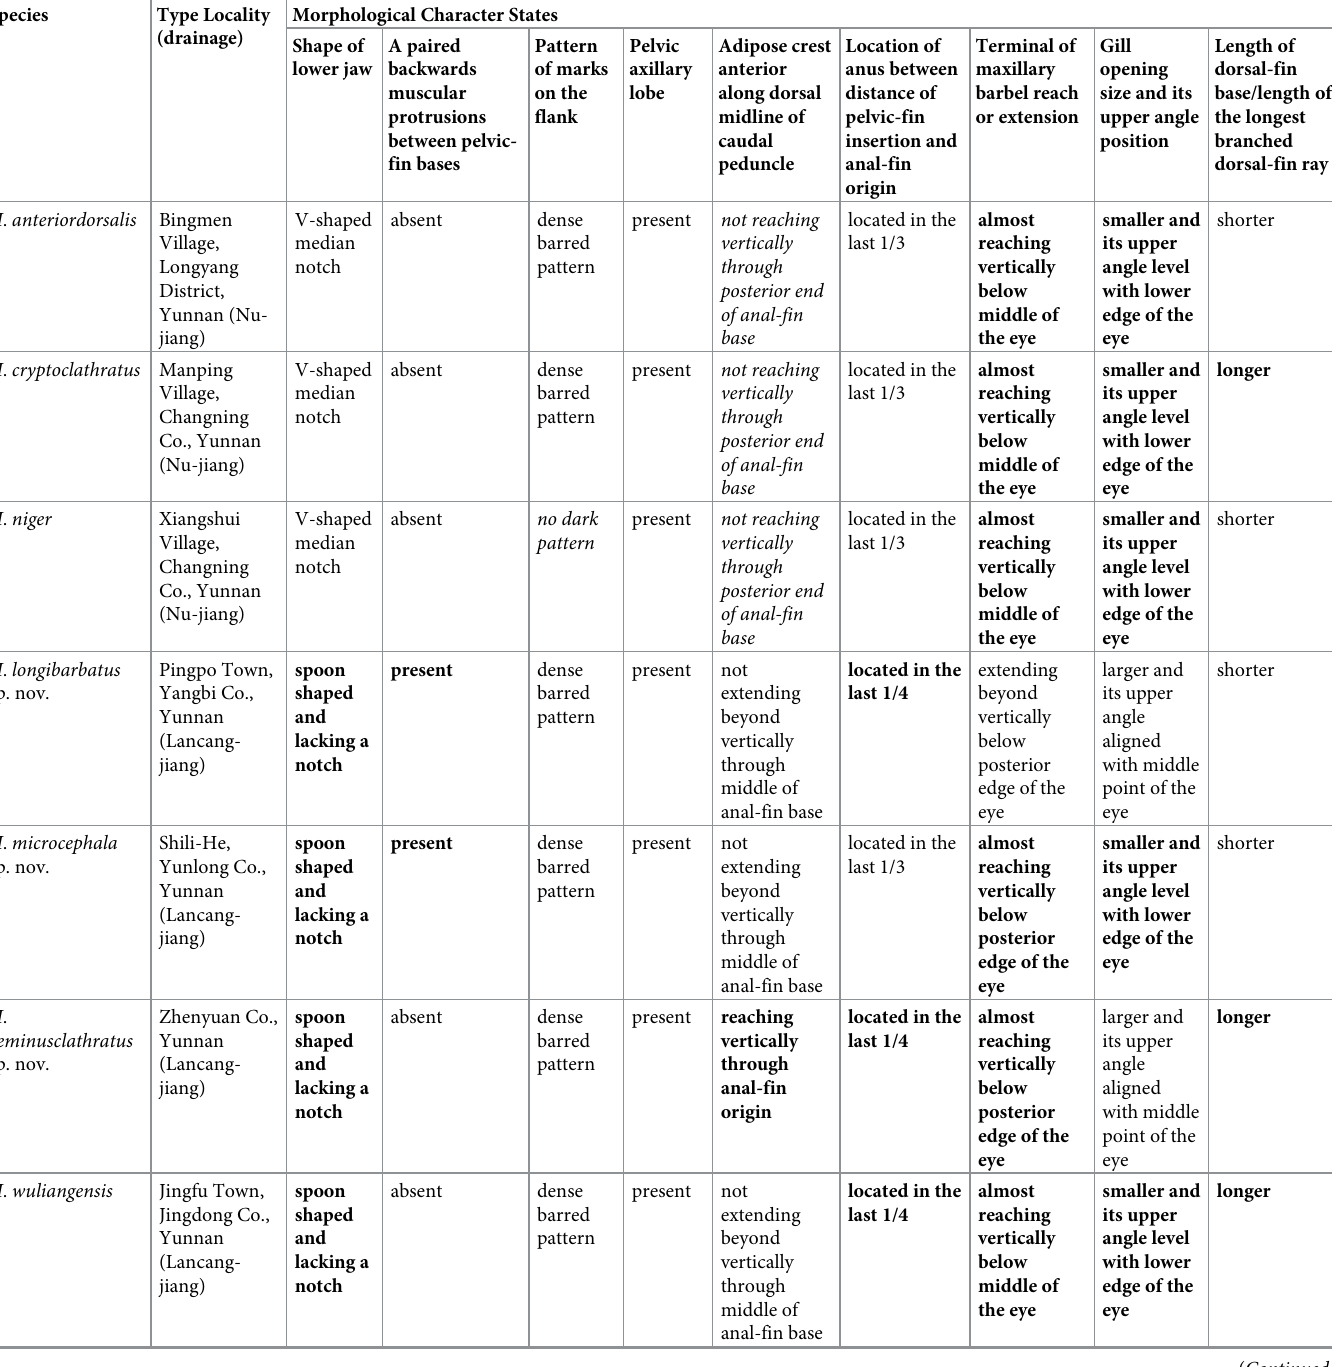
Table 2. Comparisons of characters among the species of the densely-scaled group of Homatula from the Nu-jiang (the upper Salween River), the Lancang-jiang (the upper Mekong River), and the upper Black River (a tributary of the Red River) in Yunnan Province, China.